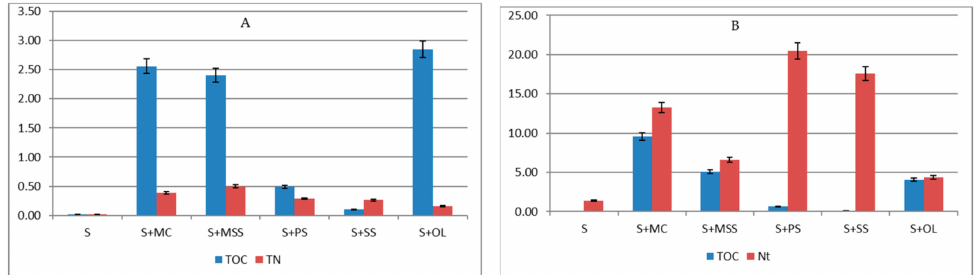
Figure 1. Changes in TOC and TN content between the initial and final incubation stages expressed in g kg − 1 ( A ) and % ( B